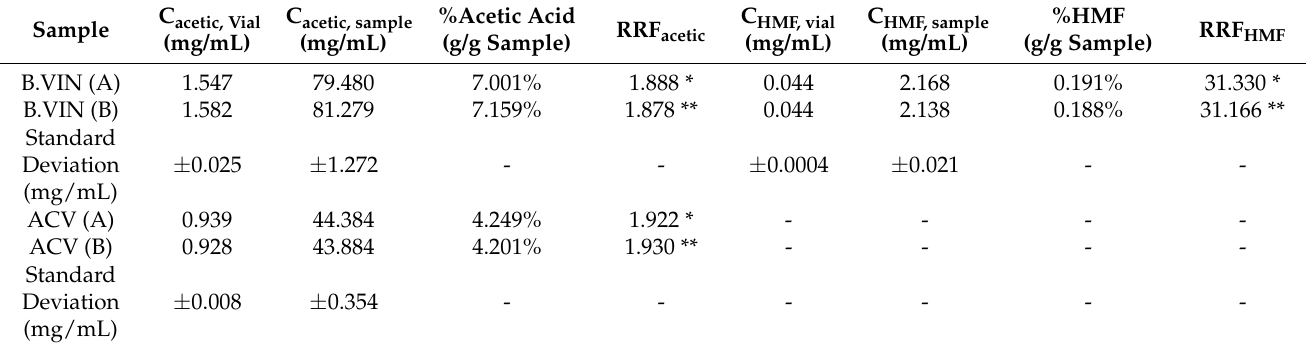
Table 3. Concentrations of species in vial: Ci, vial (mg/mL), calculated concentration of species in commercial product: Ci, sample (mg/mL), and relative response factor (RRF) of each species based on LA (ISD):